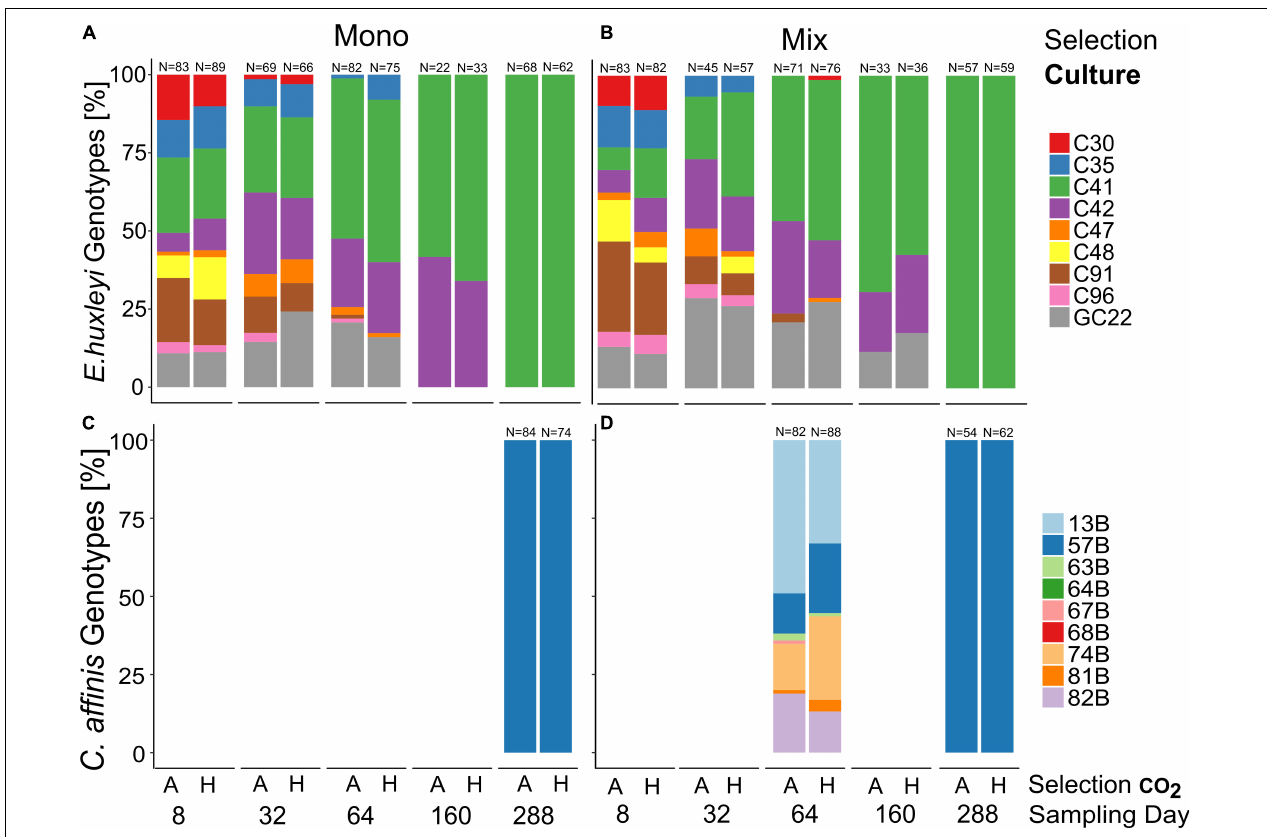
FIGURE 4 | Genotype sorting over approx. 200 generations. Relative genotype contributions in E. huxleyi (A,B) and C. affinis (C,D) experimental populations at 5 and 2 timepoints, respectively, over the course of the experiment in ambient (A) and high (H) CO 2 concentrations. Both panels on the left show the genotype contribution to the population without the second species (mono-culture) whereas the panels on the right show the contribution to the population with the respective other species (mix-culture). Re-isolation and DNA extraction of C. affinis genotypes proved difficult and we did not obtain usable data. However, the overall picture of strong genotype sorting